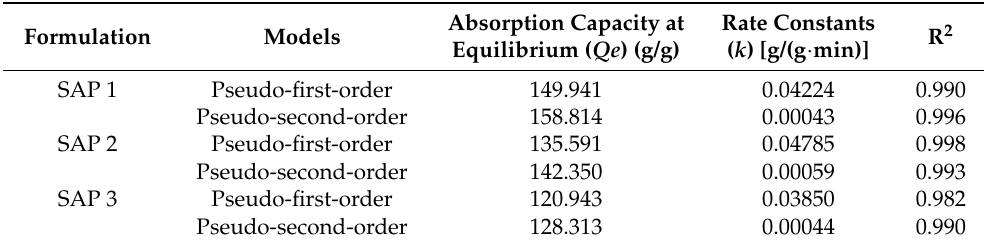
Table 2. Absorption capacity at equilibrium ( Qe ) and rate constants obtained using Swelling Kinetic Models for SAP 1, SAP 2, and SAP 3.